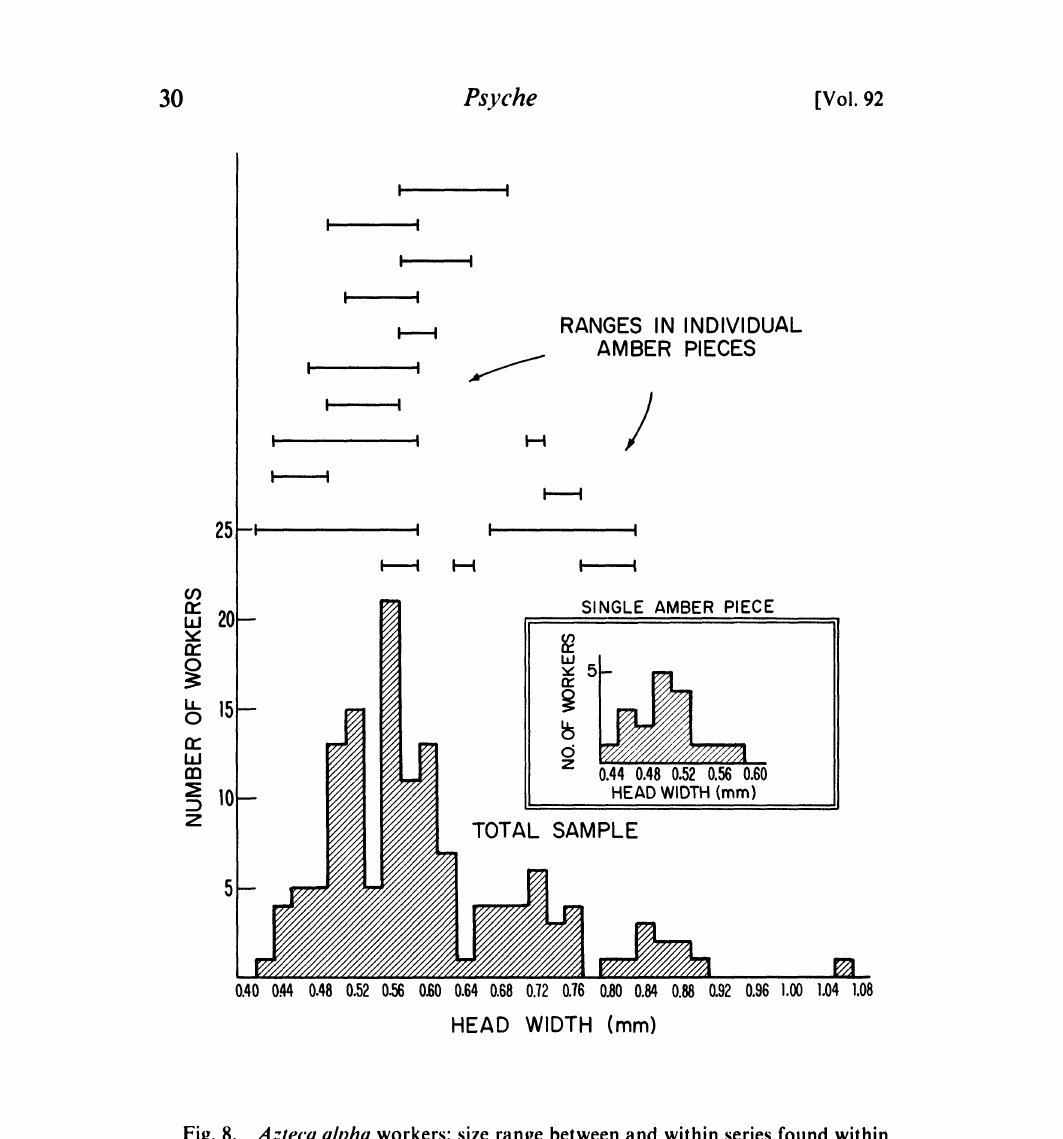
Fig. 8. Azteca alpha workers: size range between and within series found within individual amber pieces and hence assumed to belong to the same colony. The larger frequency curve (bottom in.l’igure) includes all of the 141 workers measured. The smaller frequency curve (enclosed in rectangle) includes the measurable workers from one of the most populous pieces. The series of horizontal bars (uppermost infigure) depict the ranges within single amber pieces. The samples originate variously from Carlos Diaz, La Bucara, Las Bocas del Licey, Llaroa, Los Cacaos, Palo Quemado, and still other, unknown mine sites within the Dominican